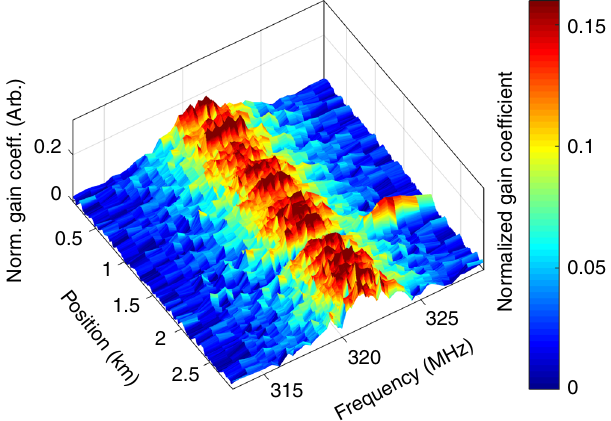
Fig. 7 Optomechanical time-domain re fl ectometry with 50m resolution. Measured nonlinear coef fi cient γ ( Ω , z ) as a function of frequency detuning Ω / (2 π ) between two co-propagating optical fi elds and position z along a fi bre under test. The nonlinear coef fi cients are normalized so that the same for all positions z . The fi bre under test had standard, dual-layer acrylate coating. Optomechanical coupling due to mode R 0,7 of the silica fi bre is observed throughout its length, with a resonance frequency of 321MHz.